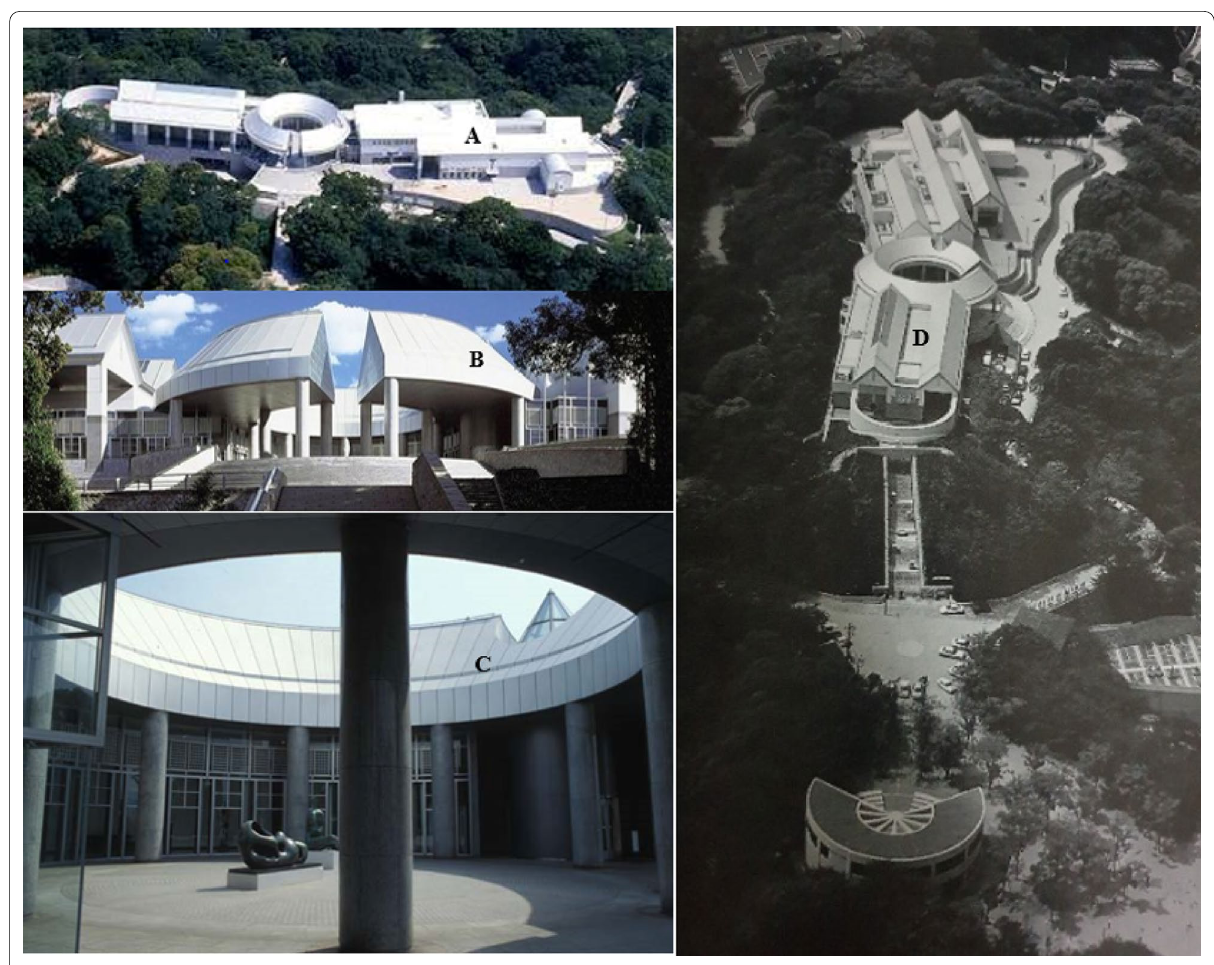
Fig. 3 Hiroshima City Museum of Contemporary Art, Hiroshima, Japan (Source: A https:// www. hiros hima- moca. jp/ en/ outli ne/, downloaded on October 21, 2019; B https:// www. archi travel. com/ archi travel/ build ing/ hiros hima- city- museum- of- conte mpora ry- art/, downloaded on October 21, 2019; C http:// jepang. pandu anwis ata. id/ 2013/ 08/ 29/ hiros hima- city- museum- of- conte mpora ry- art/, downloaded on October 21, 2019; D The Master Architect Series: Kisho Kurokawa, Selected, and Current Works (Dobney